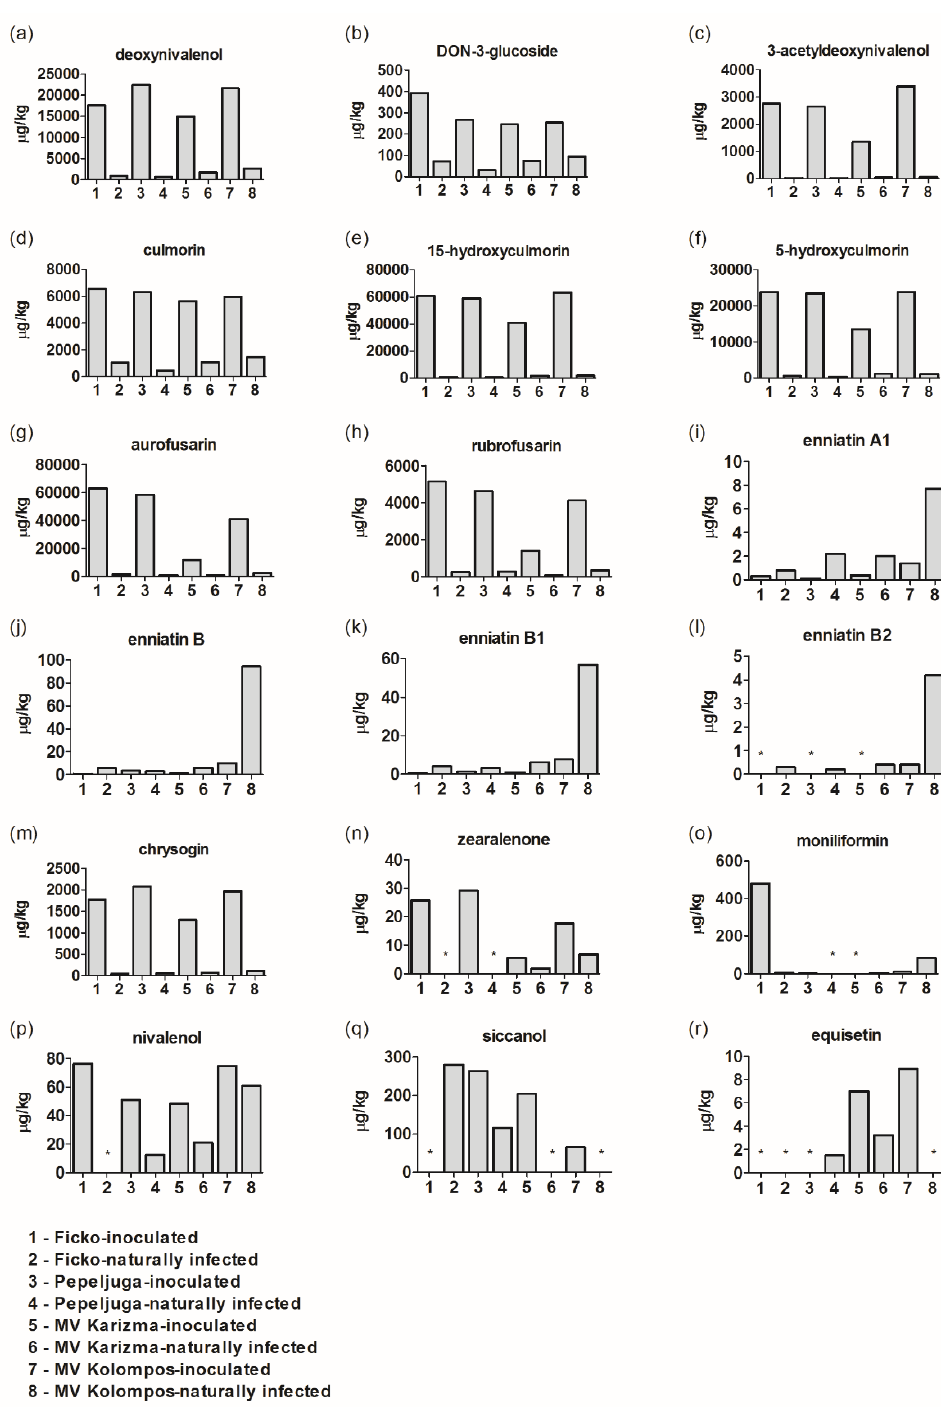
Fusarium mycotoxins / metabolites in Fusarium -inoculated and naturally-infected samples: deoxynivalenol ( a ), DON-3-glucoside ( b ), 3-acetyldeoxynivalenol ( c ), culmorin ( d ), 15-hydroxyculmorin ( e ), 5-hydroxyculmorin ( f ), aurofusarin ( g ), rubrofusarin ( h ), enniatin A1 ( i ), enniatin B ( j ), enniatin B1 ( k ), enniatin B2 ( l ), chrysogin ( m ), zearalenone ( n ), moniliformin ( o ), nivalenol ( p ), siccanol ( q ), and equisetin ( r ). The asterisk (*) indicates < LOD.